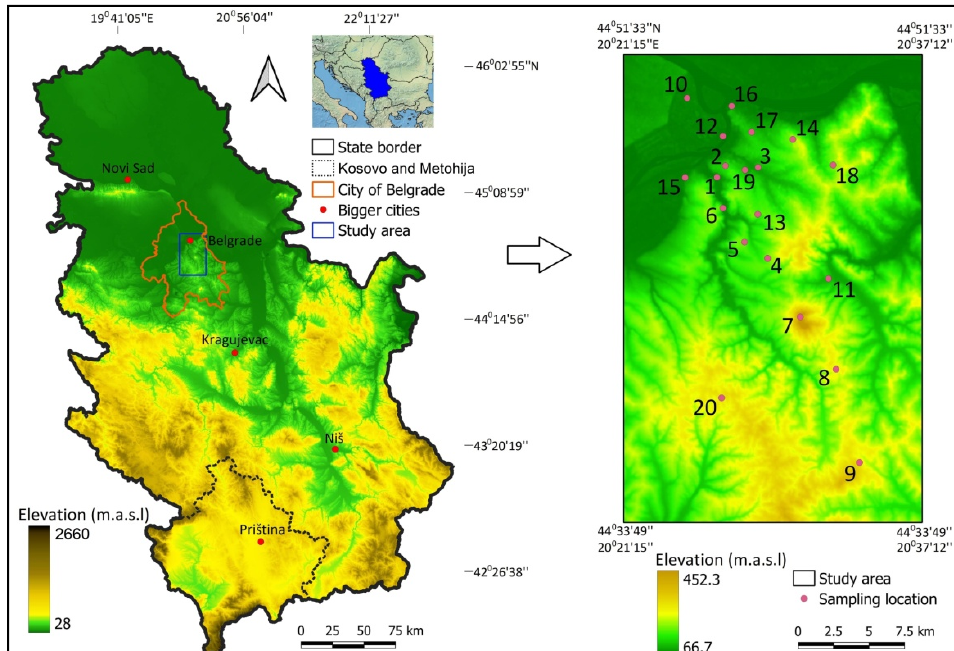
Figure 1. Map of the studied area in Belgrade, Serbia.